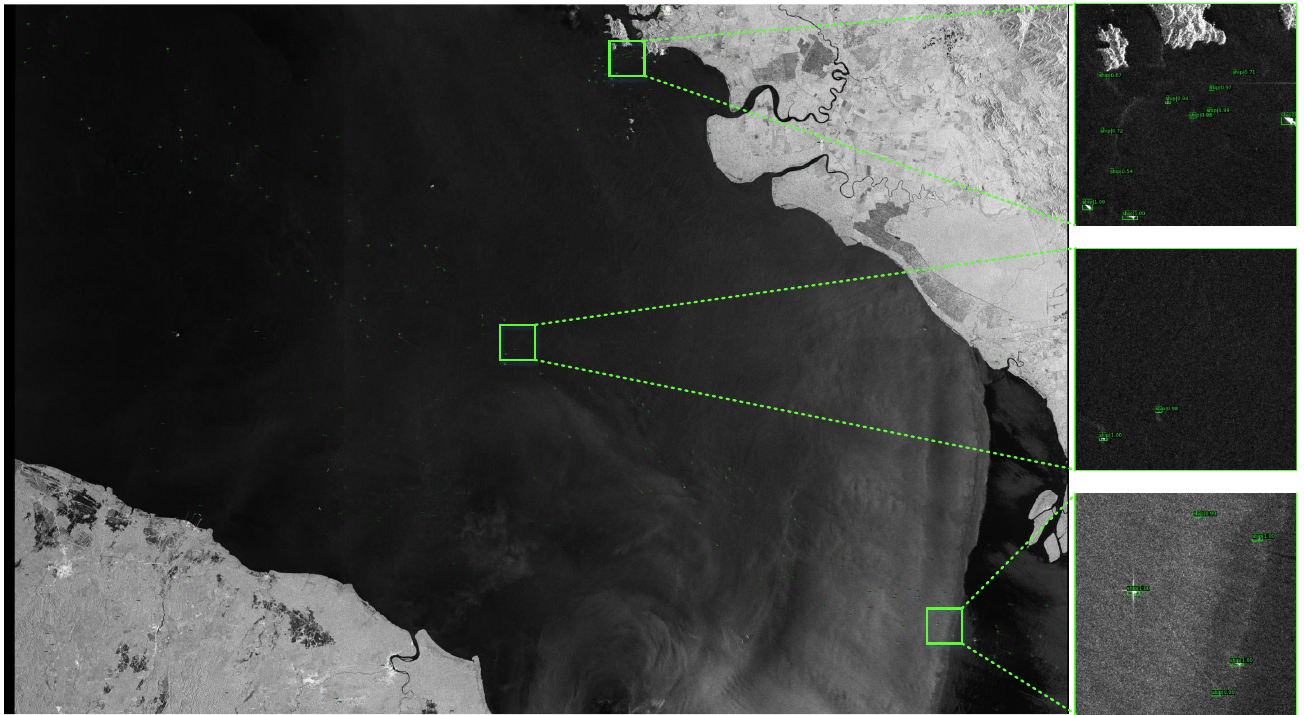
Figure 6. The visualization results are on the LS-SSDD-v1.0 dataset, where the text above the bounding box represents the ship category and confidence. The image on the right is a partial enlargement of the large-scale image. Best viewed in zoom